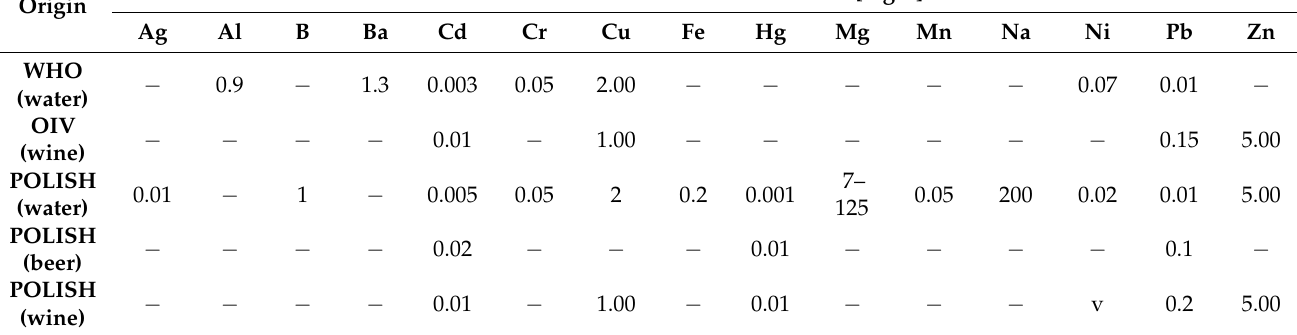
Table 1. The maximum admissible concentration of selected elements established by the Organization of Vine and Wine (OIV) (in wine) [20], the World Health Organization (WHO) (in water) [21] and by Polish legislation (in water [22], beer and wine products